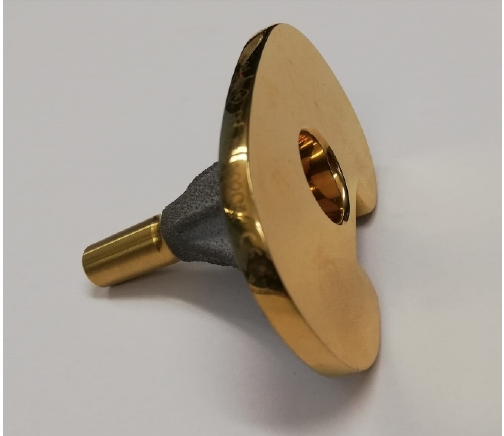
Figure 2. Tibial part of the Advanced Coated System (ACS) total knee prosthesis with the easily identifiable golden color of titanium-nitride (TiN). identifiable golden color of titanium-nitride